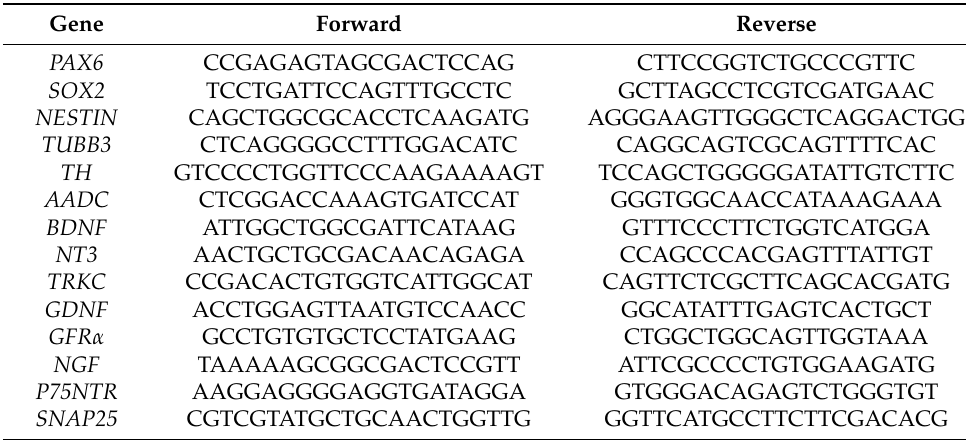
Table 9. The sequences of primers used for